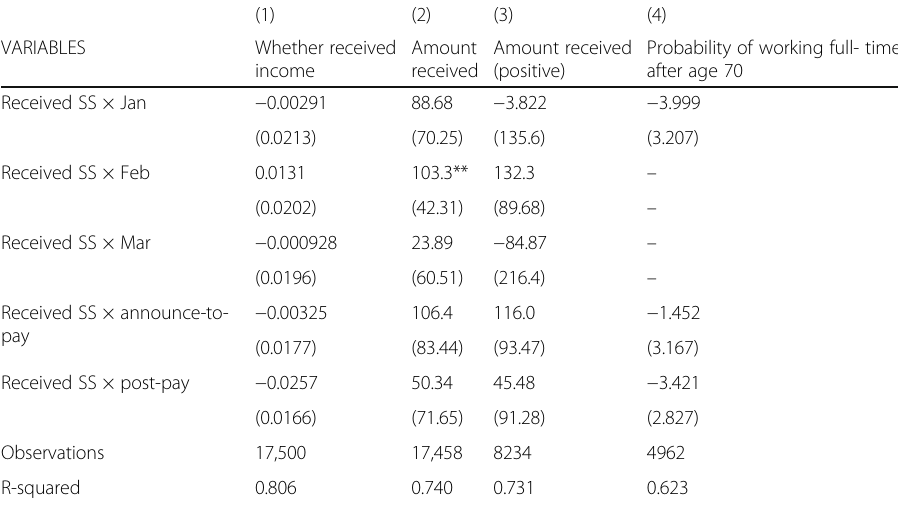
Table 10 Robustness check for labour decisions — using non-age-eligible sample as a control group (propensity score 0.2 –